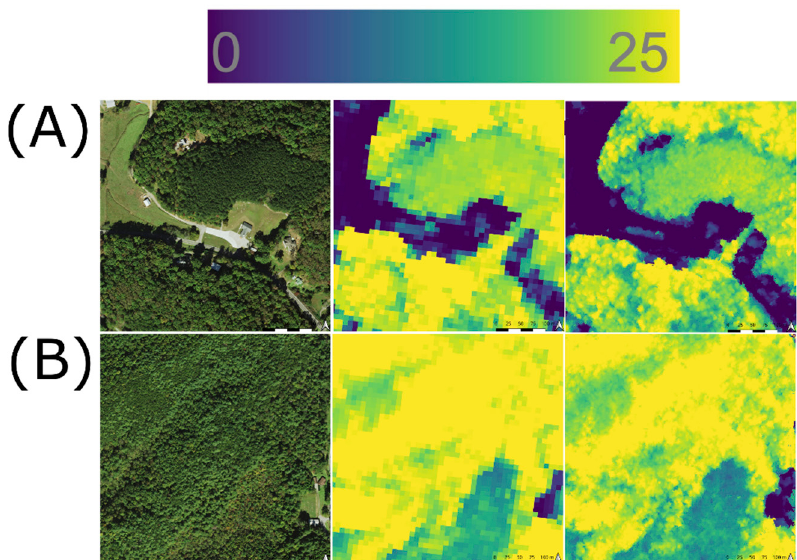
Figure 6. Differences between FIA maximum tree height and point cloud maximum height by FIA meas- urement year. Dashed red lines are drawn at +/ − 5 m and dashed black lines at zero. For the boxplots, the bottom and top of the rectangles span the 25% to 75% height range, while the thick black bars are the median values. Columns break out the plots by point cloud source (ALS or NAIP) and DEM resolution (1 m and 10 m), while rows highlight the data collected in different states (TN top, VA bottom).